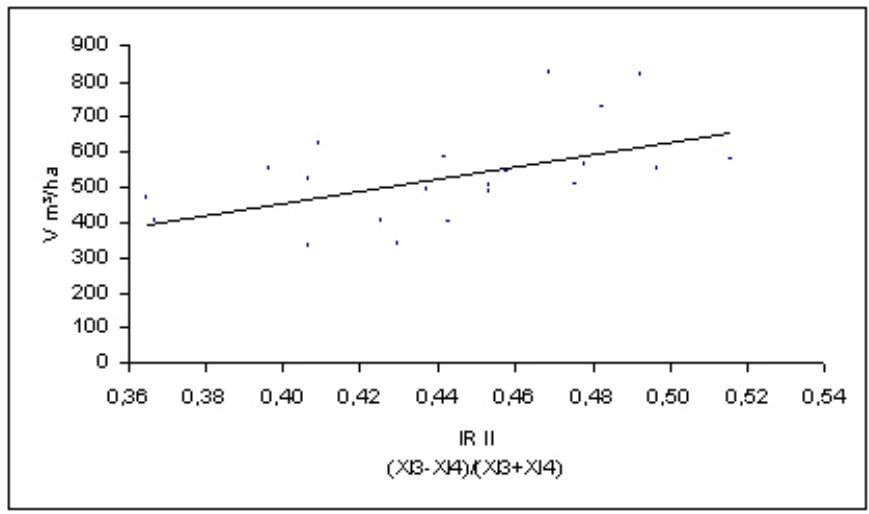
FIGURE 7 . Regression to determine the correlation between stand volume and vegetation index IR II in Lenga forests (stratum I).